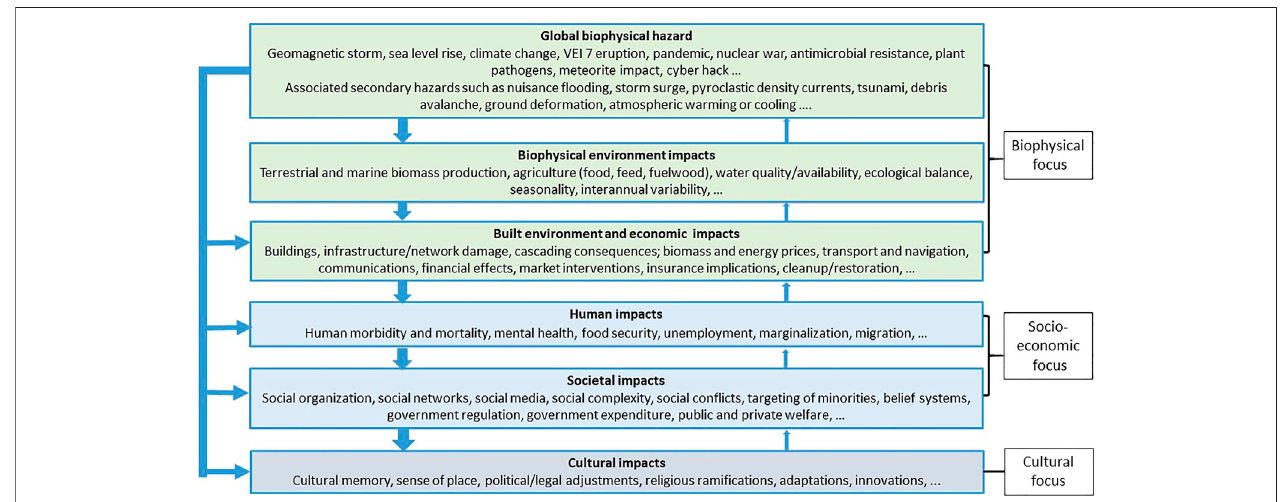
FIGURE 1 | The biophysical, social-economic and cultural strands of a global catastrophic risk (based on Luterbacher and P fi ster (2015), Torrence